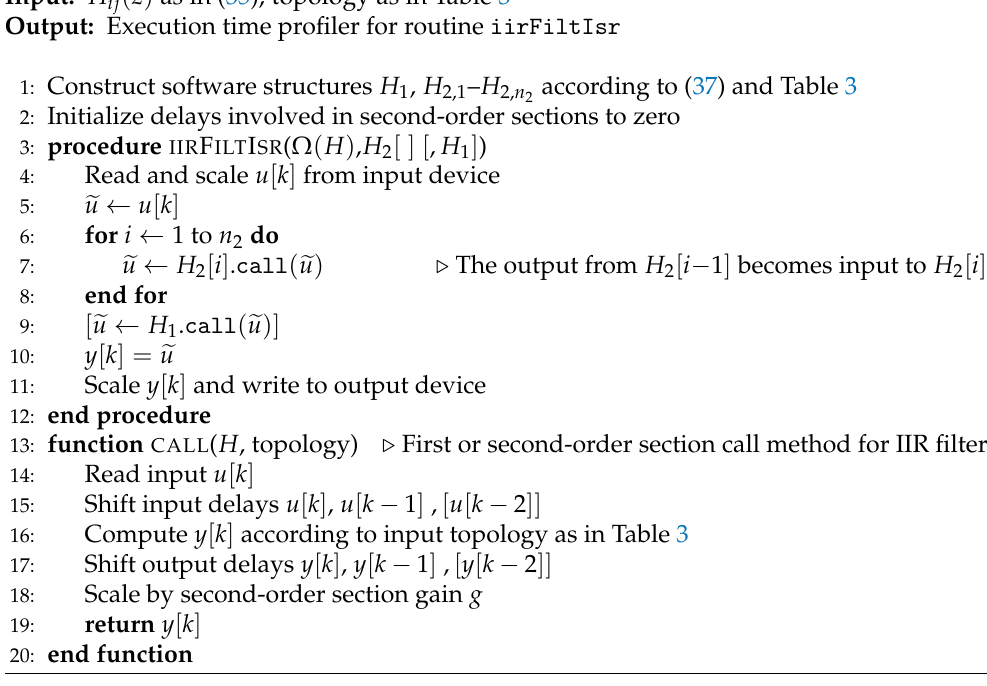
Algorithm 1 Infinite-impulse response (IIR) filter interrupt service routine